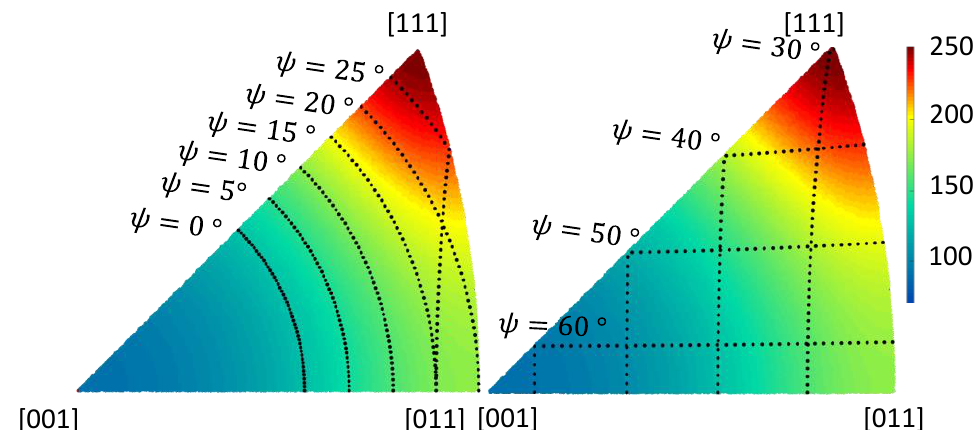
Figure 17. Inverse pole figure plot for different orientation distributions with constant value of ψ over the Young’s moduli at 850 °C.